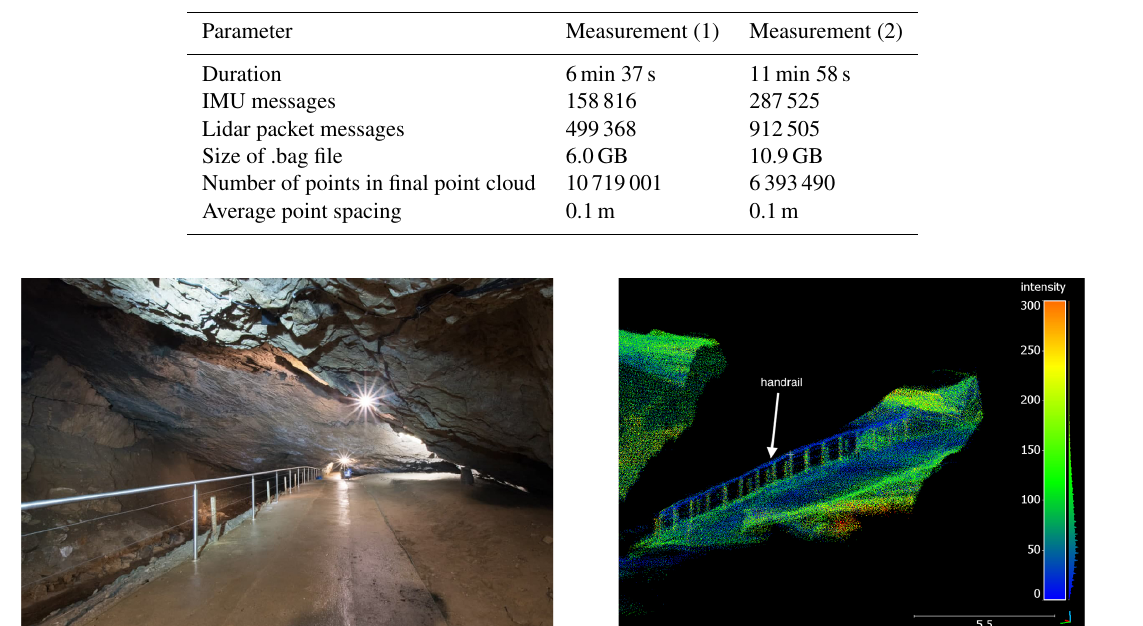
Table 1. Comparison of measurements conducted in Lurgrotte; 0.1m is the minimum average point spacing that can be produced by LIO- SAM.